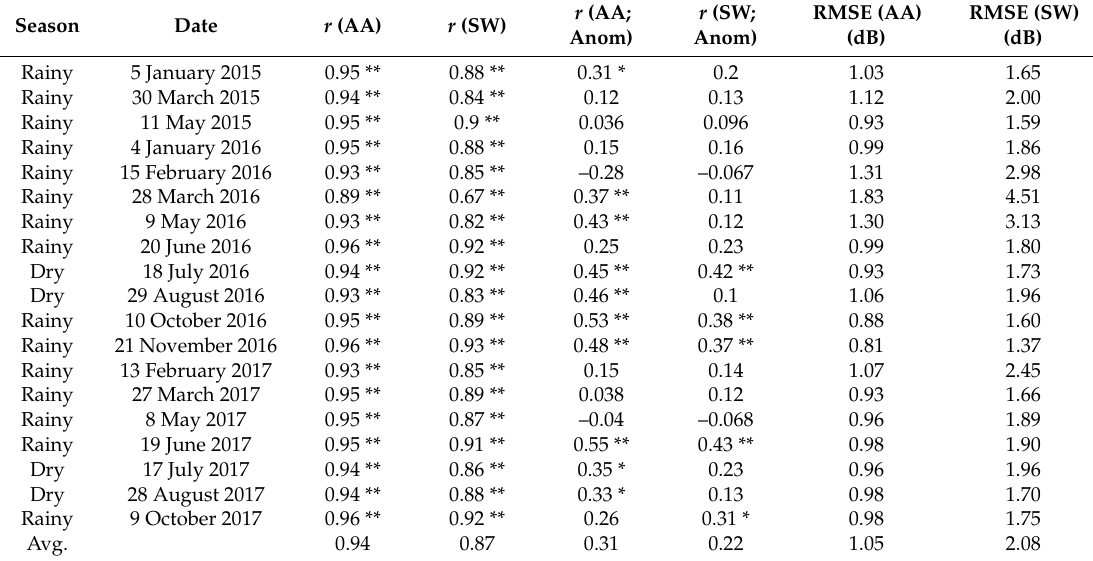
Table 2. Cross-validation results of random forest database unmixing (RFDBUX) at Lake Sentarum.